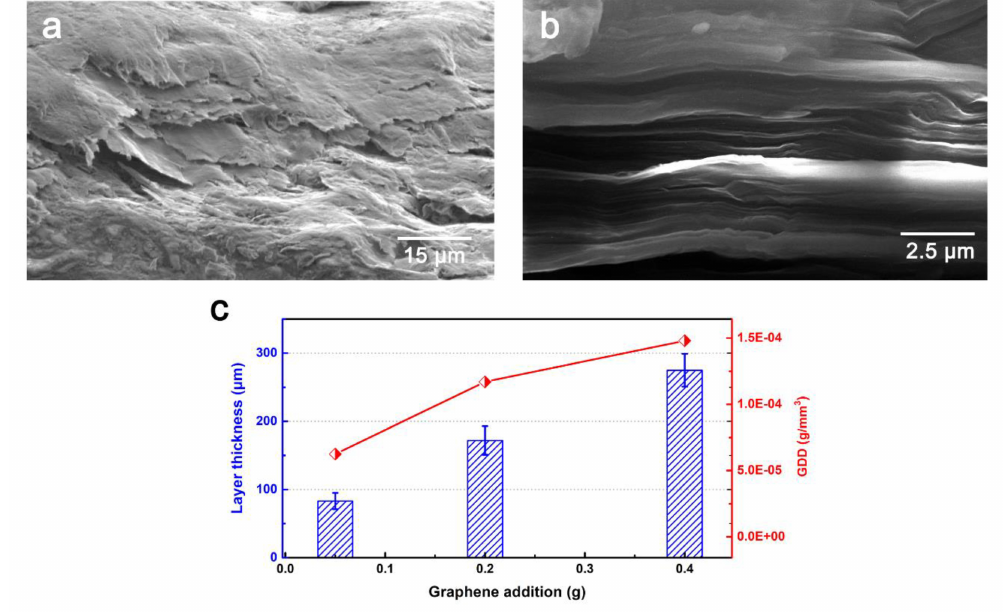
Figure 5. ( a ) Accumulation of graphene in coating preparation. ( b ) Typical appearance of graphene buckypaper prepared by vacuum filtration method. ( c ) Coating thickness and graphene distribution density (GDD) in coatings with di ff erent amounts of